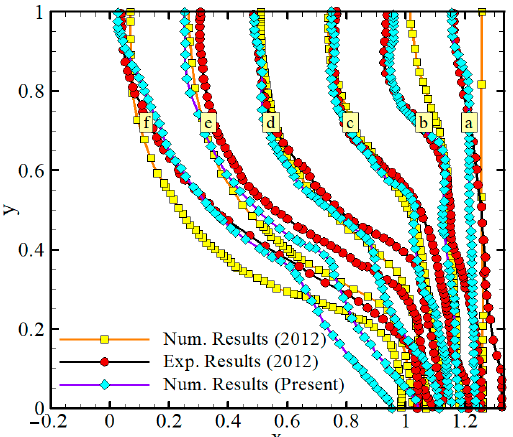
Figure 2. The experimental findings of Kumar et al. [29] and the numerical computations of the